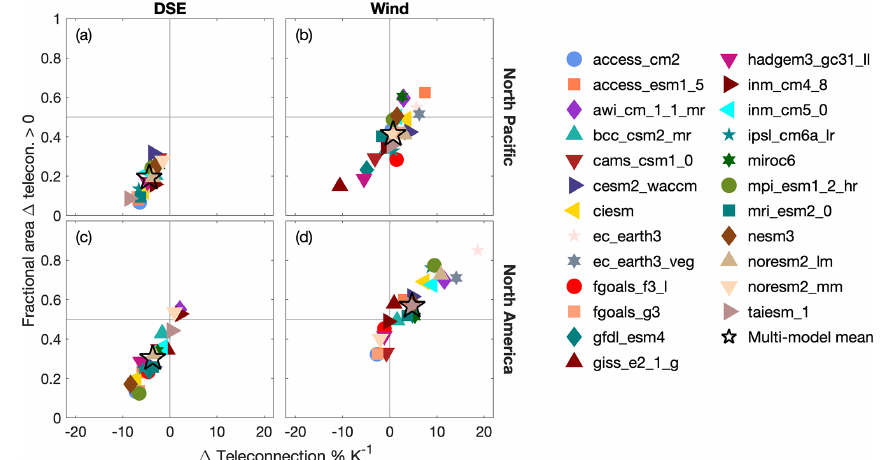
Figure 4. For individual CMIP6 model mean states and the multi-model mean, the change in the teleconnection amplitude (as a percent change per multi-model mean kelvin warming) to the North Pacific (25–70 ◦ N, 150–235 ◦ E) and North America (25–70 ◦ N, 235–290 ◦ E) between LBM simulations with mean states given by future and historical quantities. The isolated change due to (a) stability, over the North Pacific; (b) wind, over the North Pacific; (c) stability, over North America; and (d) wind, over North America. The horizontal axis is the domain mean change over the region, while the vertical axis shows the fractional area of teleconnection amplitude strengthening. DSE indicates dry static energy.